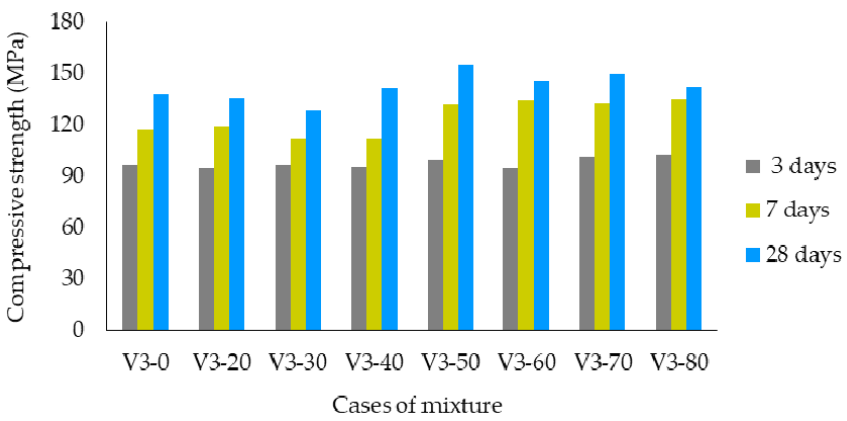
Figure 9. Compressive strength of V3 group using undensified silica fume.